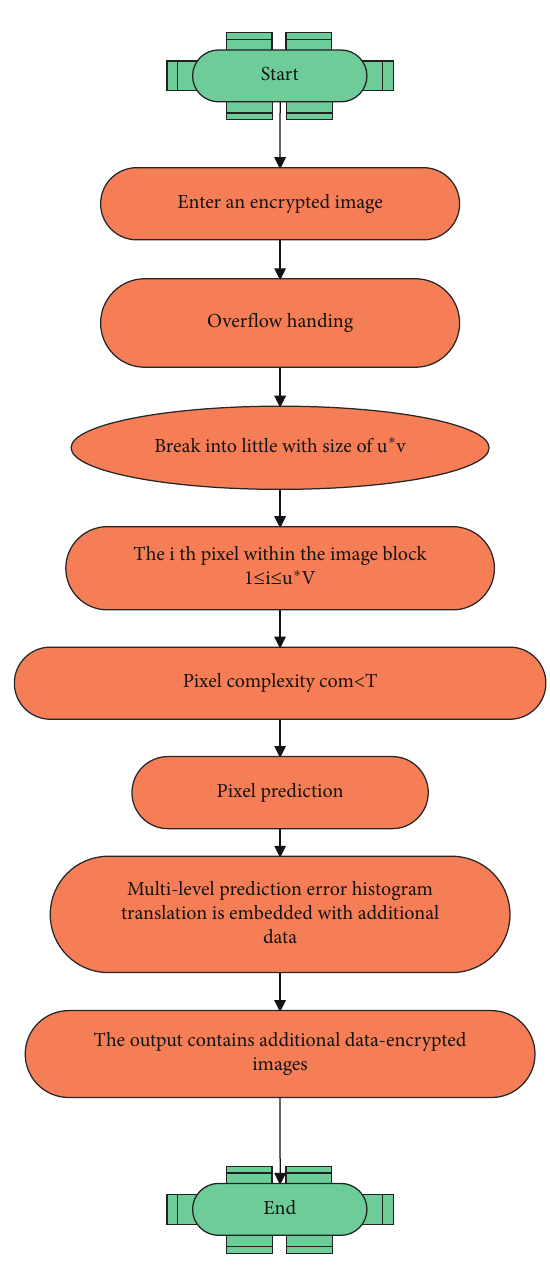
Figure 9: Flow chart of the additional data embedding